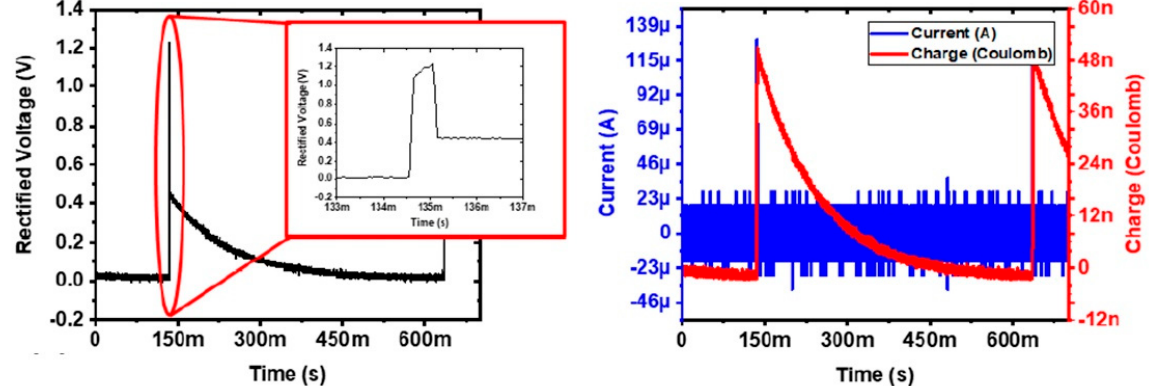
Figure 5. ( Left ) Measured rectified voltage and ( Right ) current through the load when the device is wirelessly powered at a distance of 5 mm and connected to an RC load (representing the microelectrode).